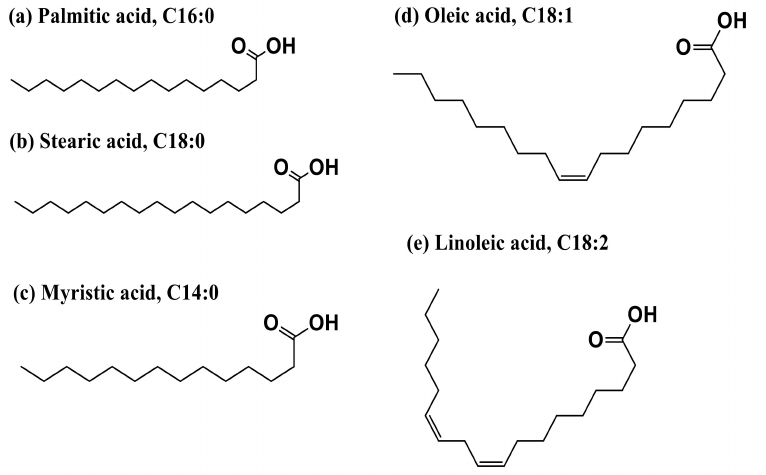
Figure 7. Chemical fatty acids structure in palm oil (C-C: saturation; C=C: unsaturation). It has high levels of saturated fatty acids, about 50% of which include palmitic (44.3%), stearic (4.6%), and myristic (1.0%). It also contains around 38.7% of oleic acid monounsaturated fatty acid and 10.5% of linoleic acid polyunsaturated fatty acid. Source: Adapted from Amir Reza, Suraya, and Azmi